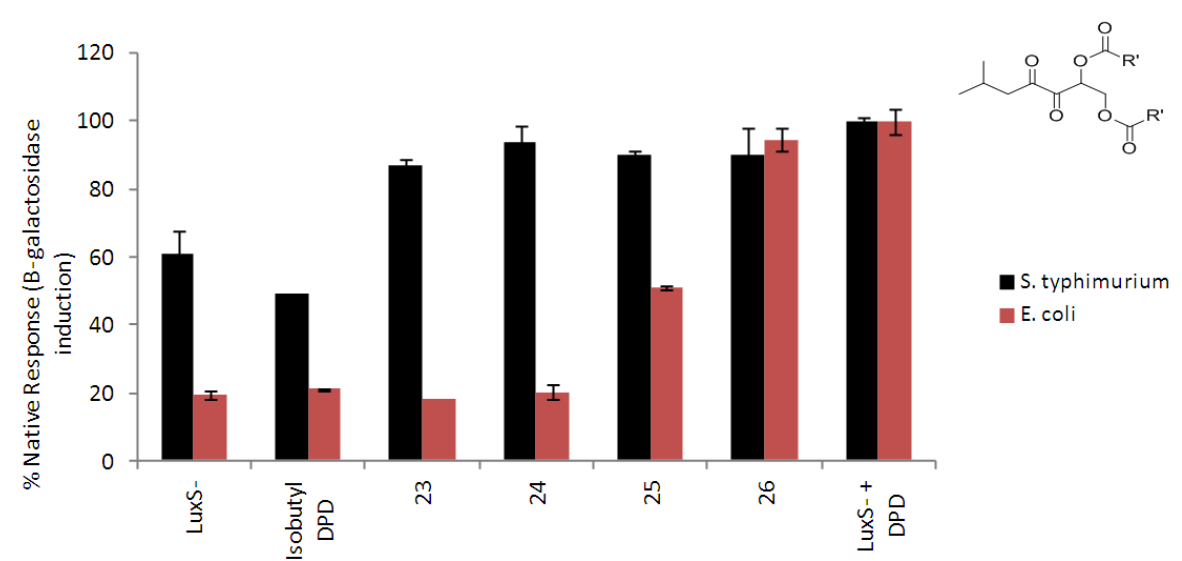
Figure 4. Inhibition of AI-2-mediated β-galactosidase expression in S. typhimurium (black bars) and E . coli (pink bars) with various bis -ester analogs of isobutyl DPD. [AI-2] = 20  M, [analogs] = 20  M. Compounds 23 – 26 represent ester protected isobutyl DPD analogs: 23 : isobutyl DPD bis- methyl ester; 24 : isobutyl DPD bis -propyl ester; 25 : isobutyl DPD bis- butyl ester; 26 : isobutyl DPD bis- pentyl